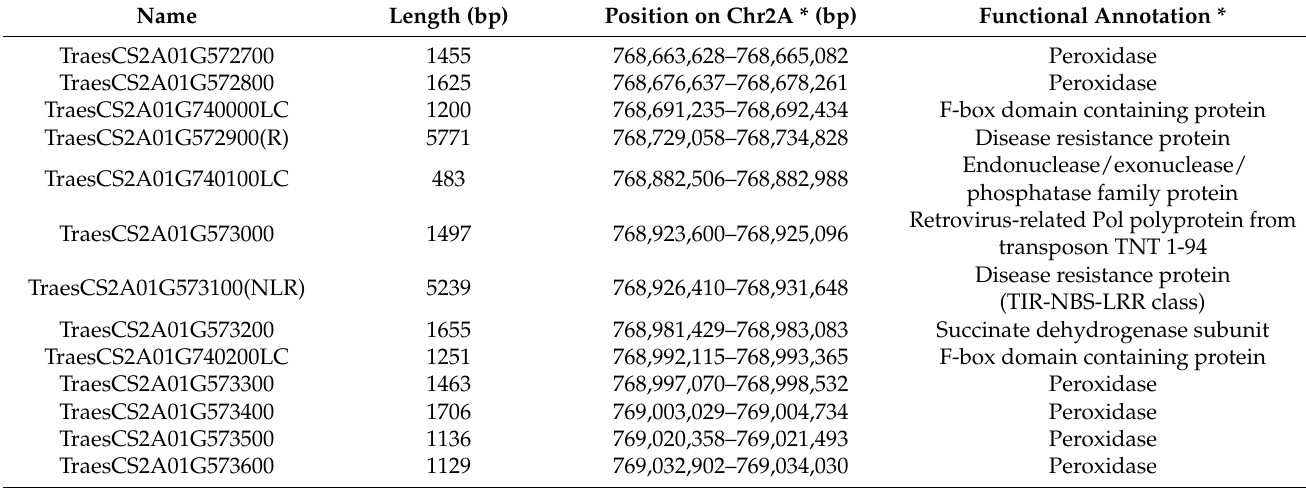
Table 3. Thirteen genes in the candidate region.